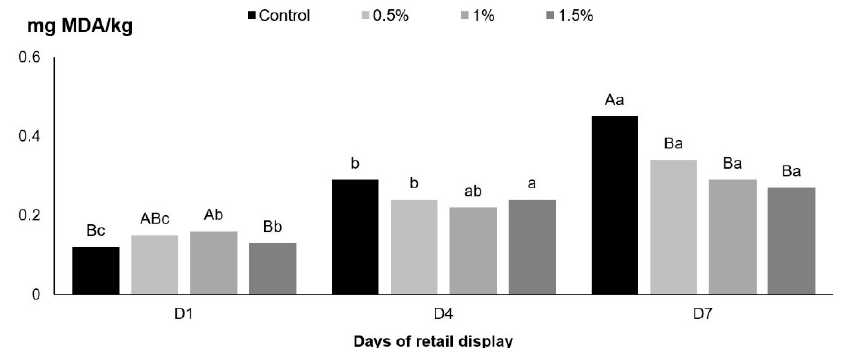
Figure 1. TBA values (mg MDA / kg) of beef patties formulated with di ff erent levels of TE (Control = 0%, 0.5%, 1%, and 1.5%). p = 0.002, Standard error of the mean = 0.01. A,B Means with di ff erent superscripts